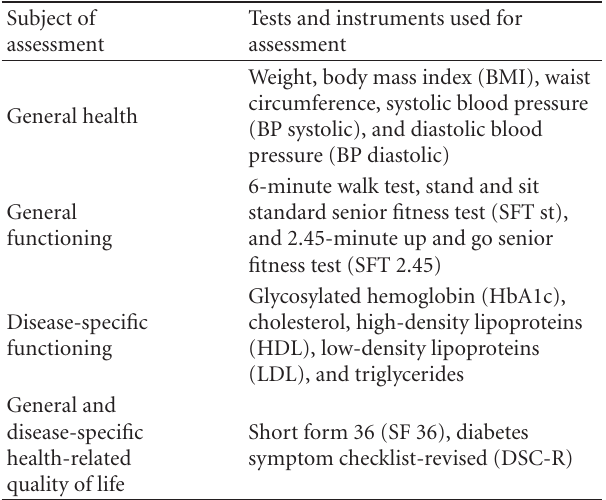
Table 1: Pre- and postintervention measurements among DM2